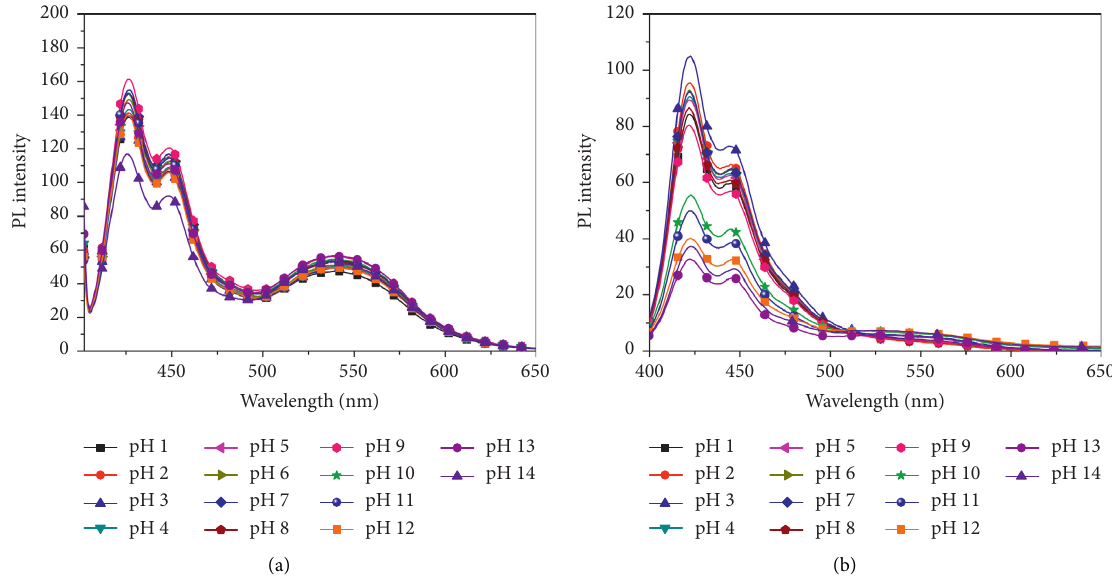
Figure 7: Emission spectra of P4 (a) and P4 ′ (b) (excitation at 384nm) at different pH